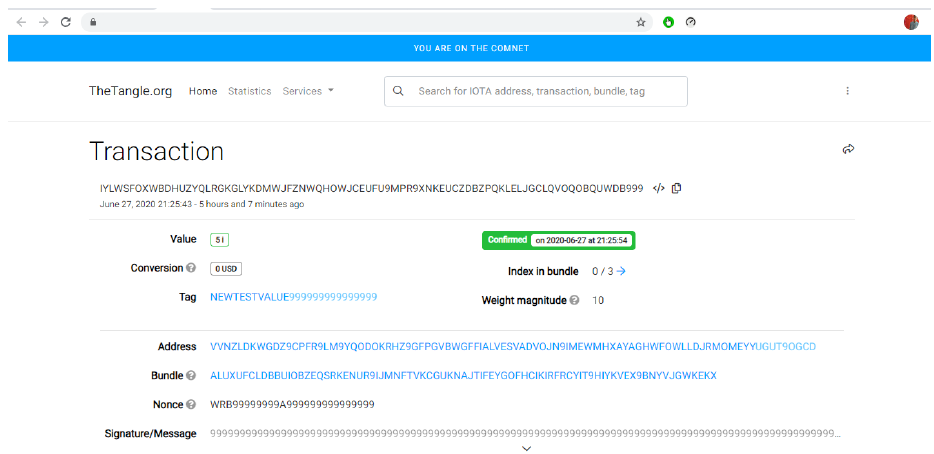
Figure 18. IOTA’s payment shown on website of comnet.thetangle.org .